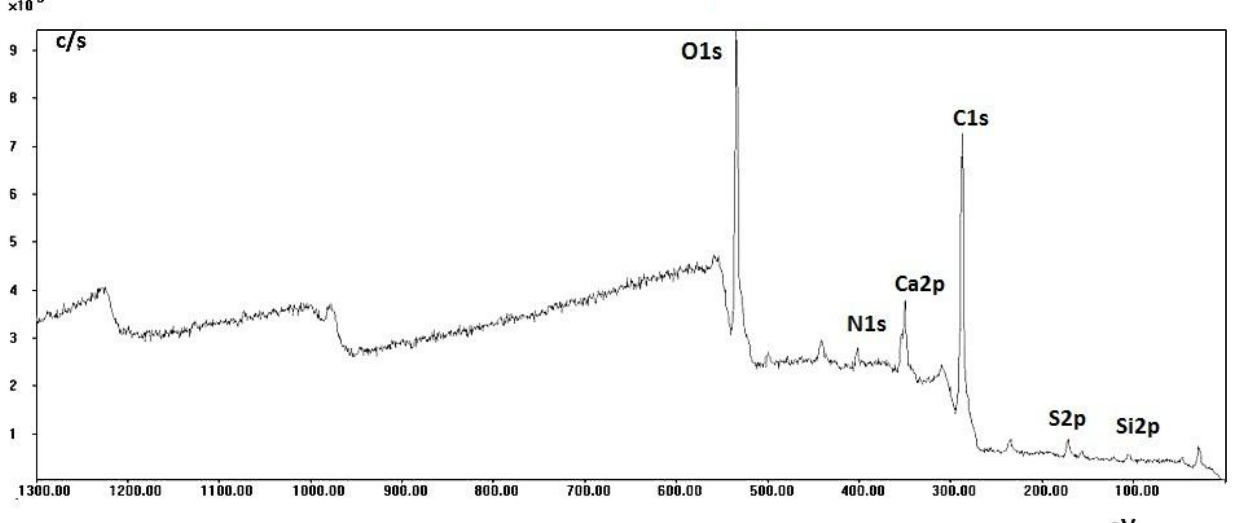
Figure 8. Sample C.3.1.1: XPS wide